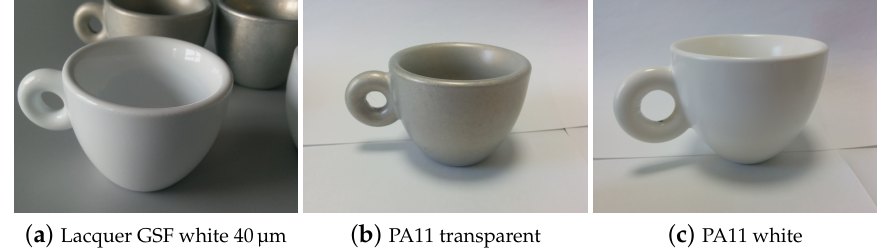
Figure 7. Prototypes of coffee cups made in AM60 magnesium alloy with different